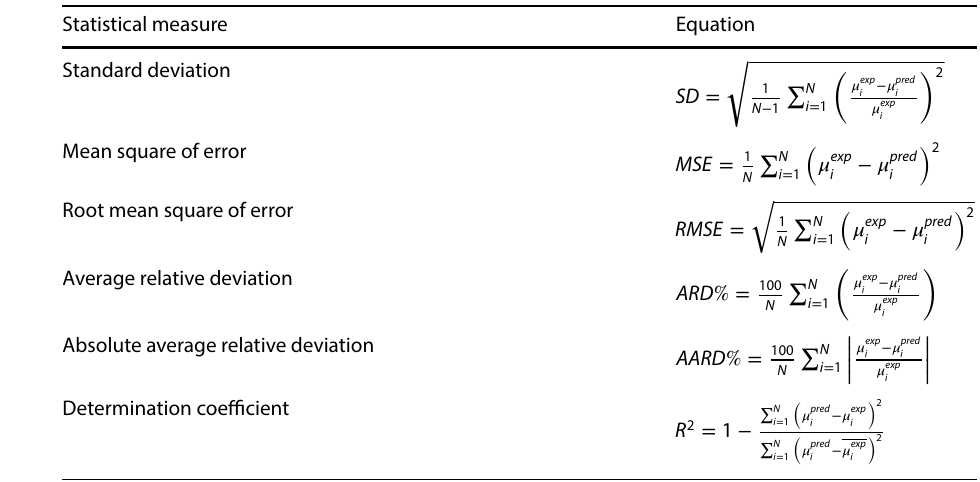
Table 4 The values of the statistical parameters for the training, test, and all data sets